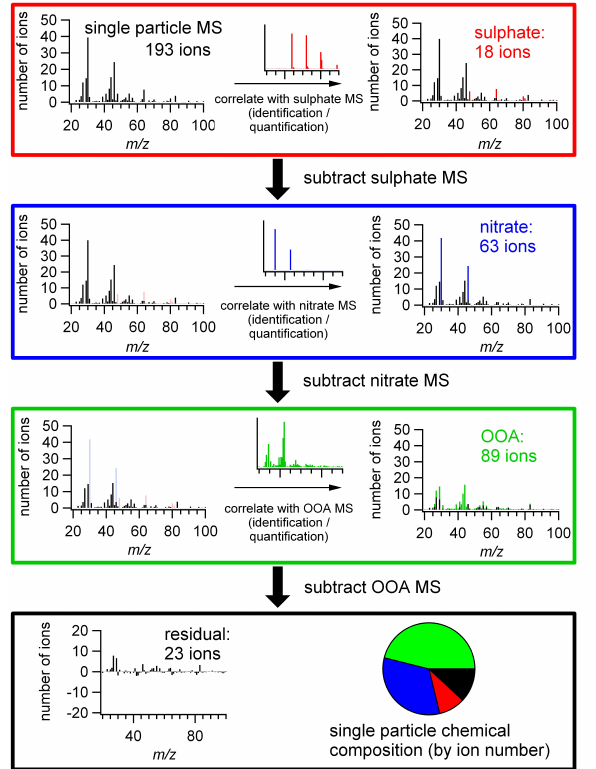
Fig. 1. Example for the application of the algorithm on one single- particle mass spectrum containing OOA, sulphate and nitrate. MS: mass spectrum.